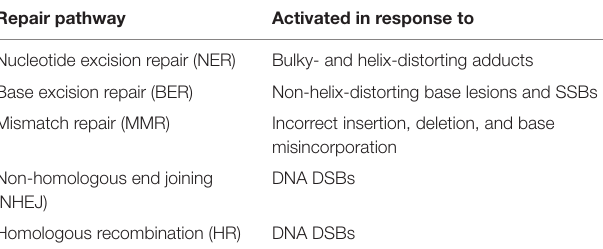
TABLe 2 | DNA repair pathways and associated